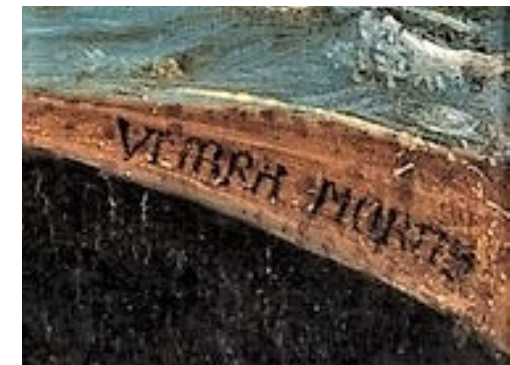
Figure 7. Detail of Figure 1.